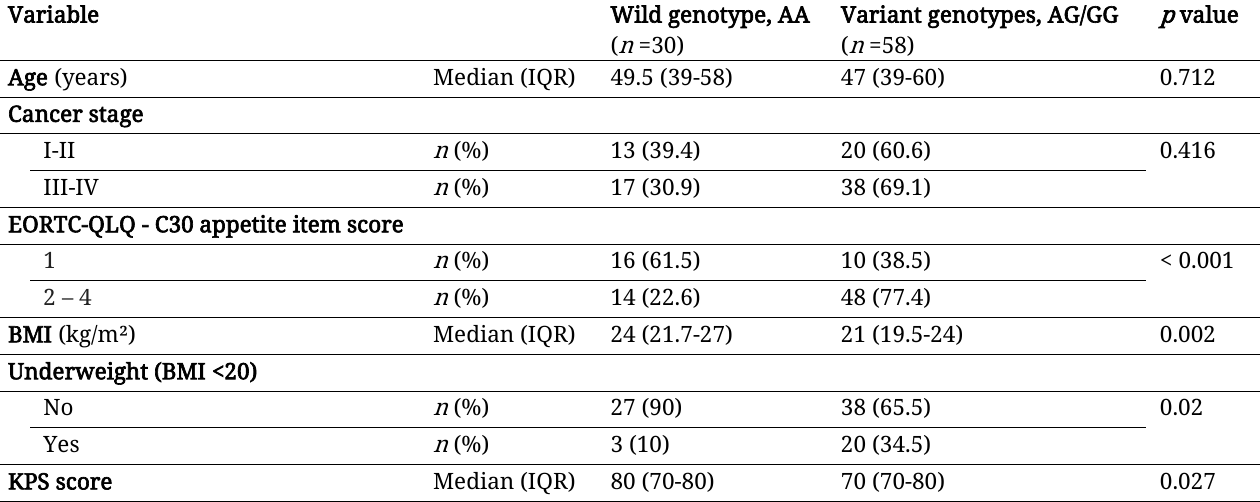
Table 2: Comparing variables according to IL-10 polymorphism Variable